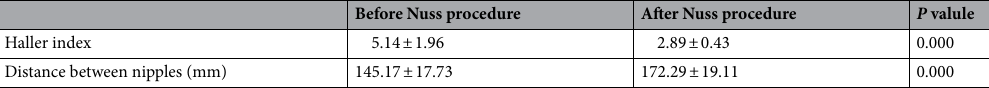
Table 2. Changes of the Haller index and distance between nipples before and after modified Nuss procedure.